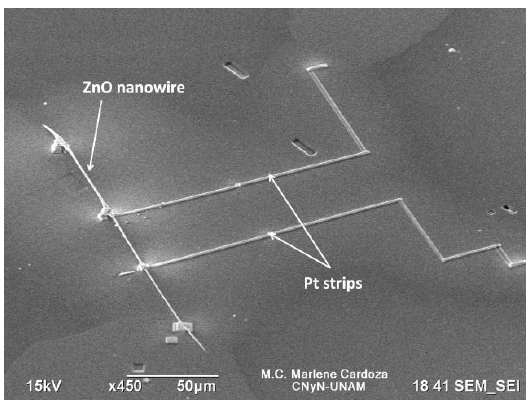
Figure 1. SEM image of fabricated single ZnO nanowire gas sensor device (M 1 ).